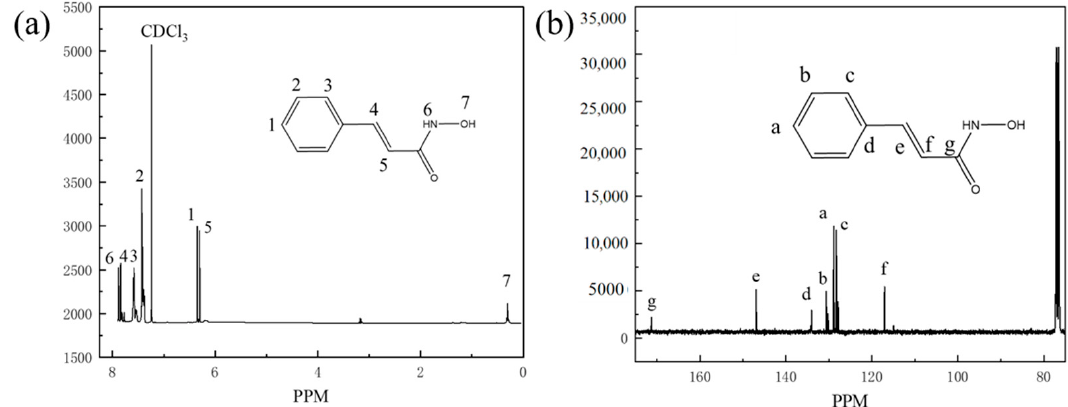
Figure 3. 1 H-NMR ( a ) and 13 C-NMR ( b ) pattern of PHA.